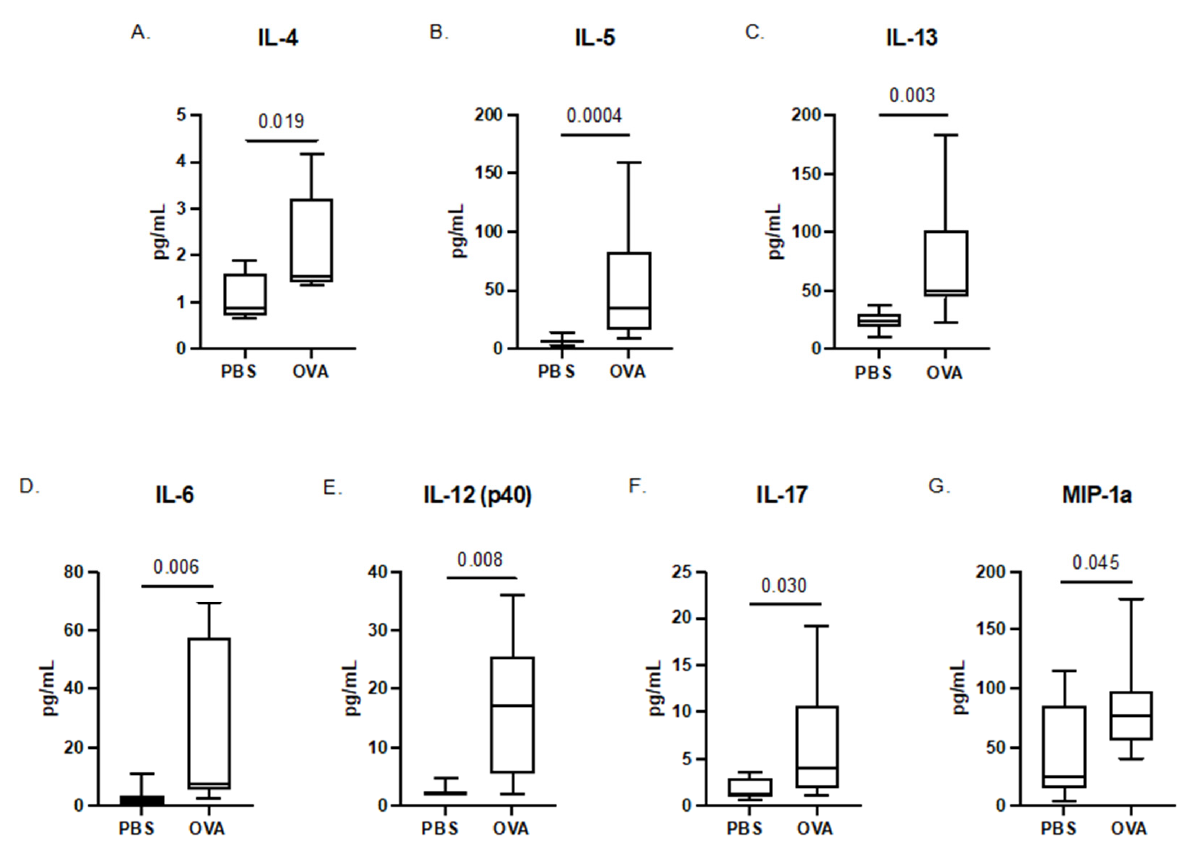
Figure 1. Cytokine concentrations in maternal sera of dams exposed to PBS and OVA taken at GD17.5. Serum was collected prior to fetal offspring and placenta collections. Cytokine levels were assessed using a multiplex bead-based immunoassay. ( A ) IL-4, ( B ) IL-5, ( C ) IL-13, ( D ) IL-6, ( E ) IL-12 (p40), ( F ) IL-17, and ( G ) MIP-1 α are represented as pg/mL after being normalized to total protein content. Statistical significance determined by Mann–Whitney U test. PBS dams n = 8, OVA dams n = 10.